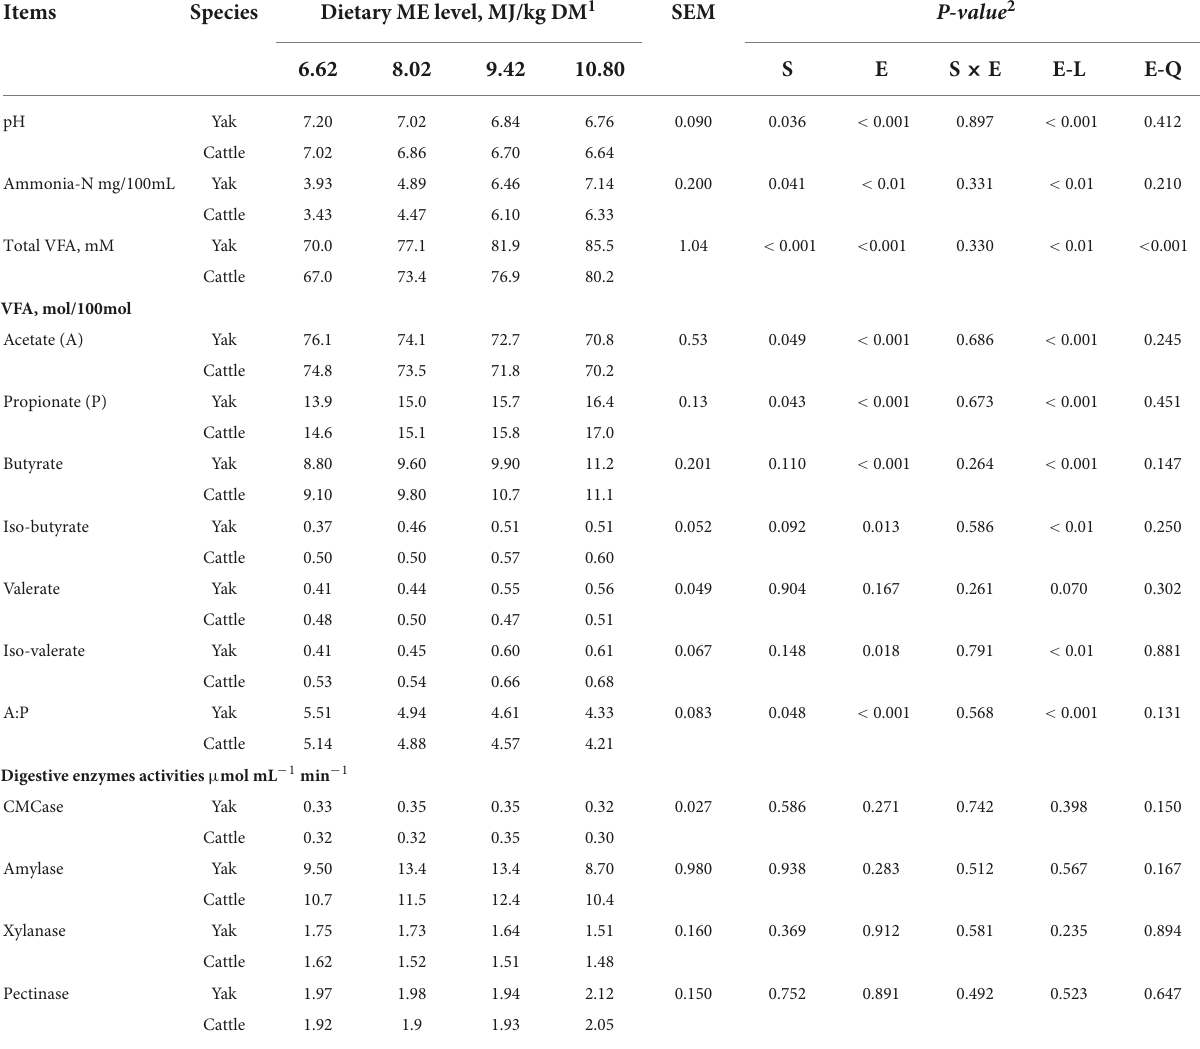
TABLE 2 Ruminal fermentation parameters and enzyme activities in yaks and cattle offered diets of different energy levels.